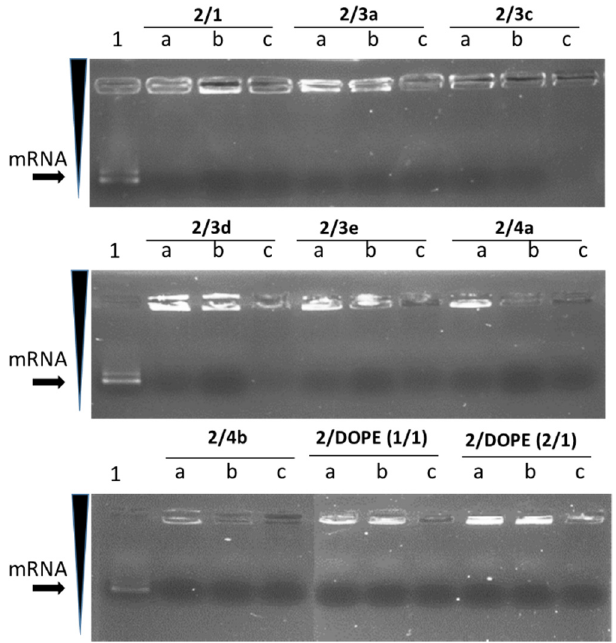
Figure 2. Agarose gel electrophoresis of LXs. mRNA was complexed with 2 -based liposomes at mRNA/liposomes charge ratios of 1/0.5 (a), 1/1 (b) and 1/2, (c). Lane 1 was mRNA in the absence of liposomes. Then, LX were analyzed on a 0.6% agarose gel. Gel running buffer was TAE (40 mM Tris-acetate, 1 mM EDTA). mRNA gel was stained with ethidium bromide (EtBr) at a concentration of 0.5 µ g/mL. mRNA fluorescence was revealed under UV